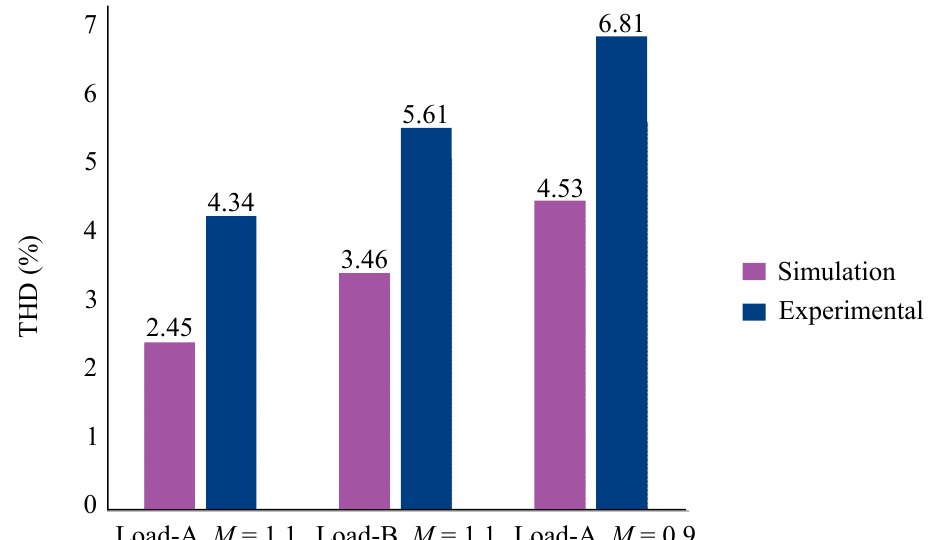
Figure 14. Inverter current THD at different